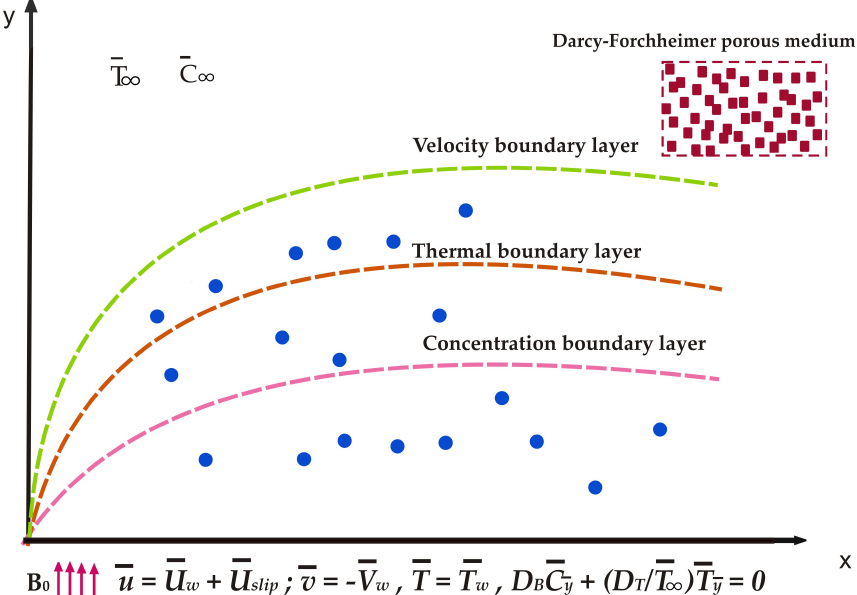
Figure 1. Physical model of